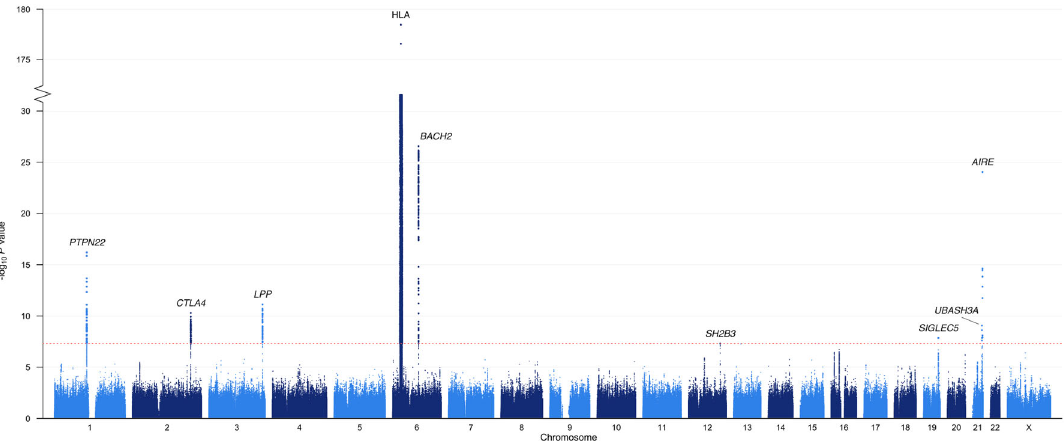
Fig. 1 Manhattan plot for the genome-wide association study of autoimmune Addison ’ s disease with 1223 cases and 4097 controls. The – log 10 P values from logistic regression on the y -axis are plotted against their physical chromosomal position on the x -axis for all SNPs across chromosomes 1 – 22 and X. Labels correspond to the prioritized or nearest genes. The dotted red bar marks the genome-wide signi fi cance level ( P ≤ 5 × 10 − 8 ). The y- axis has been gapped to include the top SNP in the HLA